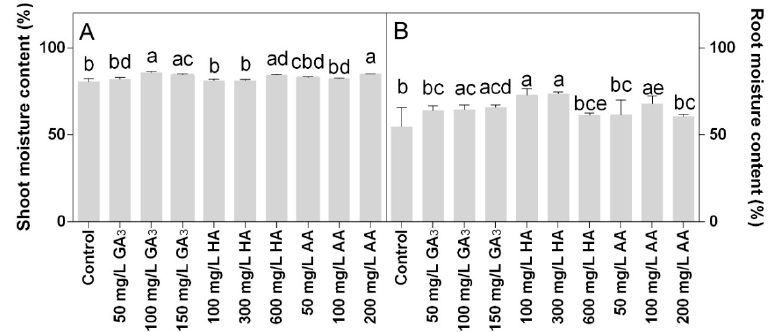
Figure 7. Effect of gibberellic acid (50–100–150 mg/L GA), humic acid (100–300–600 mg/L HA),